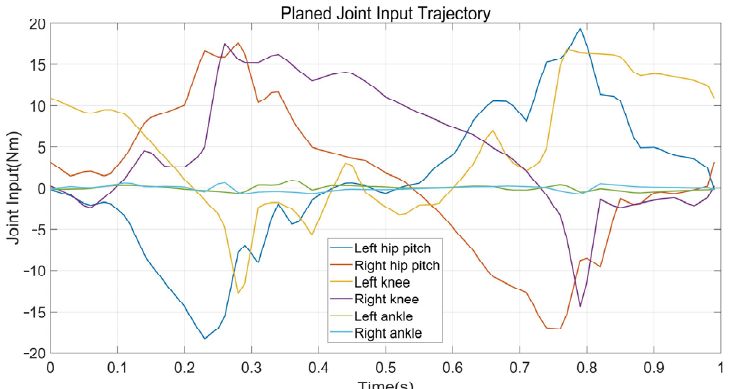
Figure 5. The planned input trajectory of planar walking on flat terrain.